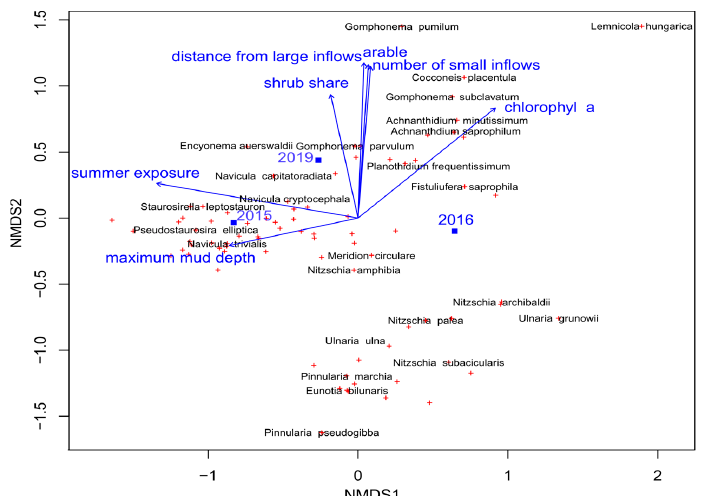
Figure 12. N MDS ordination diagram of species composition of diatom assemblages of the Dehtá ř Figure 12. NMDS ordination diagram of species composition of diatom assemblages of the Deht á ˇr fishpond with passively projected selected environmental and management factors. All continuous factors are significantly correlated with species composition ( p ≤ 0.01; 999 permutations). The envfit function from the vegan package (Oksanen [93]) was used for the calculations. Explanations of abbreviated names of selected factors: summer exposure = extent of bottom exposure in summer, shrub share = % share of shrubs in the buffer zone between open water and the surrounding landscape, arable = surrounding landscape with prevailing arable land, chlorophyll-a = chlorophyll-a concentrations (mean for the relevant site and growing season), 2015, 2016, 2019 = years of the diatom sampling. For a more detailed explanation of individual variables, see Table